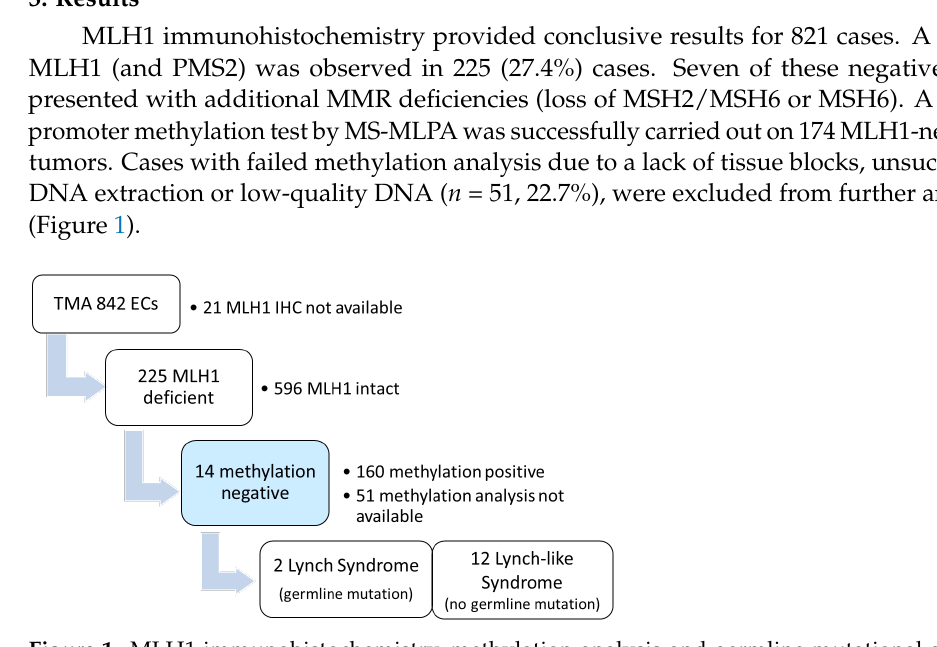
Figure 1. MLH1 immunohistochemistry, methylation analysis and germline mutational analysis performed o 821 unselected EC cases (clinic-based cohort). All cases with multiple MMR anomalies were MLH1 methylation-linked. Pertinent clinicopathological characteristics of the 174 MLH1-negative cases forming our clinic- based study cohort are shown in Table 1. Table 1. Clinicopathologic data (n = 174 *).